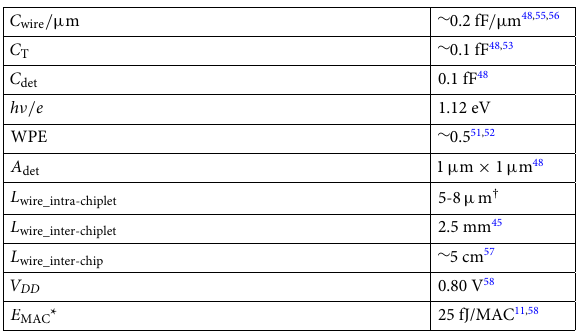
† Table 2. Parameters. We assume a square multiplier and scale reported 8-bit multiplier areas in a 45 nm node 59–61 to a 7 nm node (the current state of the art) with the scaling factors from literature 58 . A MAC unit comprises both an 8-bit multiplier and a 32-bit adder, so we are placing a lower bound on the minimum length 2 of L wire . Recent work 62 optimizes MAC units for DNNs, and reports a 337 µ m area in a 28 nm node, where the MAC unit comprises an 8-bit multiplier and a 32-bit adder. Extrapolated to a 7 nm node with a fourth-order 2 polynomial fit of the scaling factors from literature 58 , the MAC unit is of size ( 7 µ m ) , which falls within the 5-8 µ m range. * E MAC , the energy required for one multiply-and-accumulate, shown for